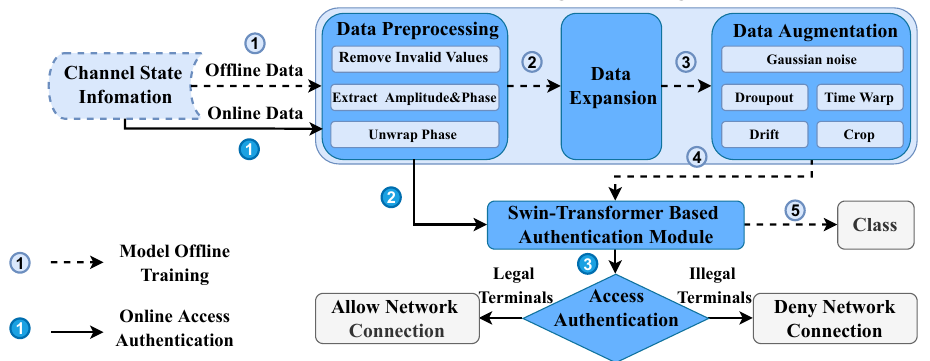
Figure 2. The Unified Trusted Access Authentication (UTAA)